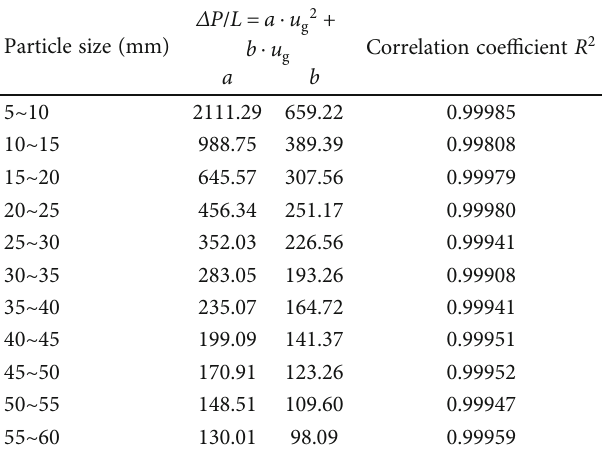
Table 4: Coe ffi cients of the fi tting function between the pressure drop per unit height ( Δ P / L ) and gas velocity ( u of particle